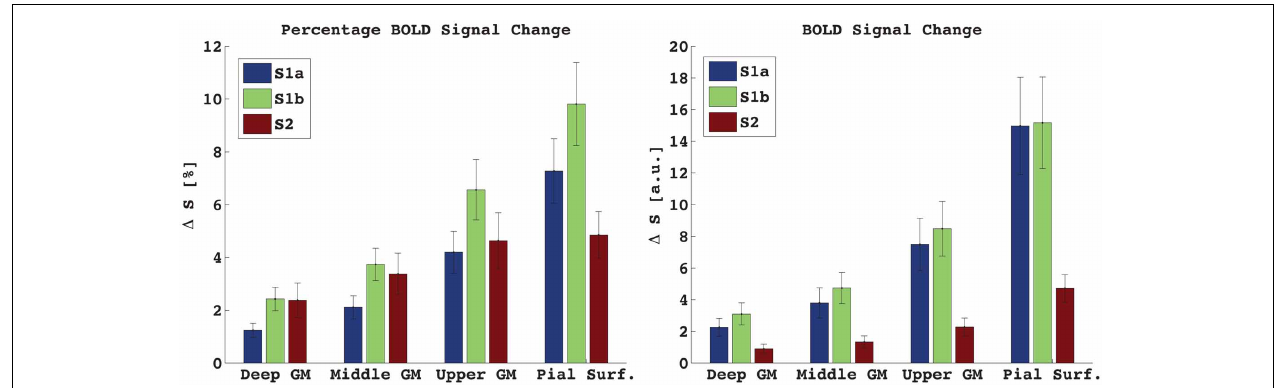
FIGURE 3 | Percentage (left) and absolute (right) signal change in GM and at the pial surface. S1a, TE = 7ms, S1b, TE = 17ms. Mean ± s.e.m., n = 7. Due to low GM-CSF contrast in S1, the absolute and percentage signal